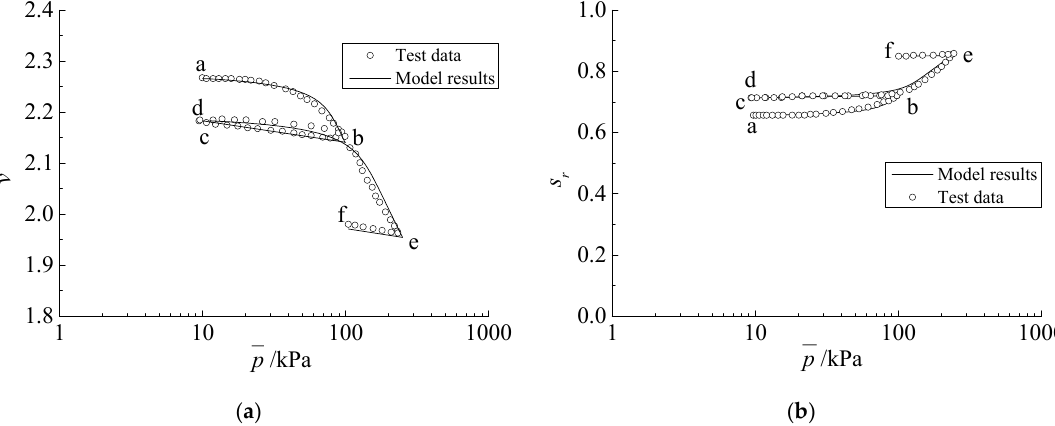
Figure 6. Comparison between modeling results and Test 9 measured data for bentonite/kaolin mixture under isotropic loading–unloading cycles: ( a ) specific volume; ( b ) saturation degree.